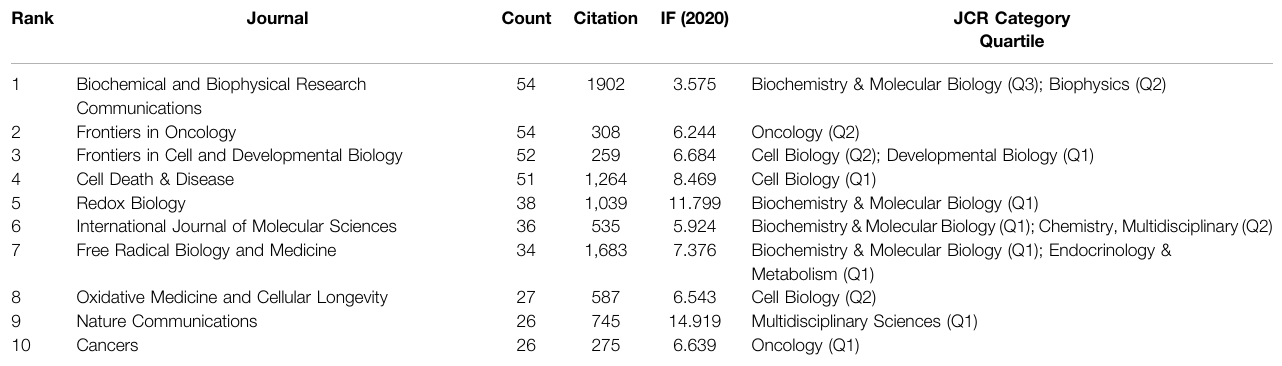
TABLE 5 | Top 10 journals published papers of ferroptosis research in cancer.